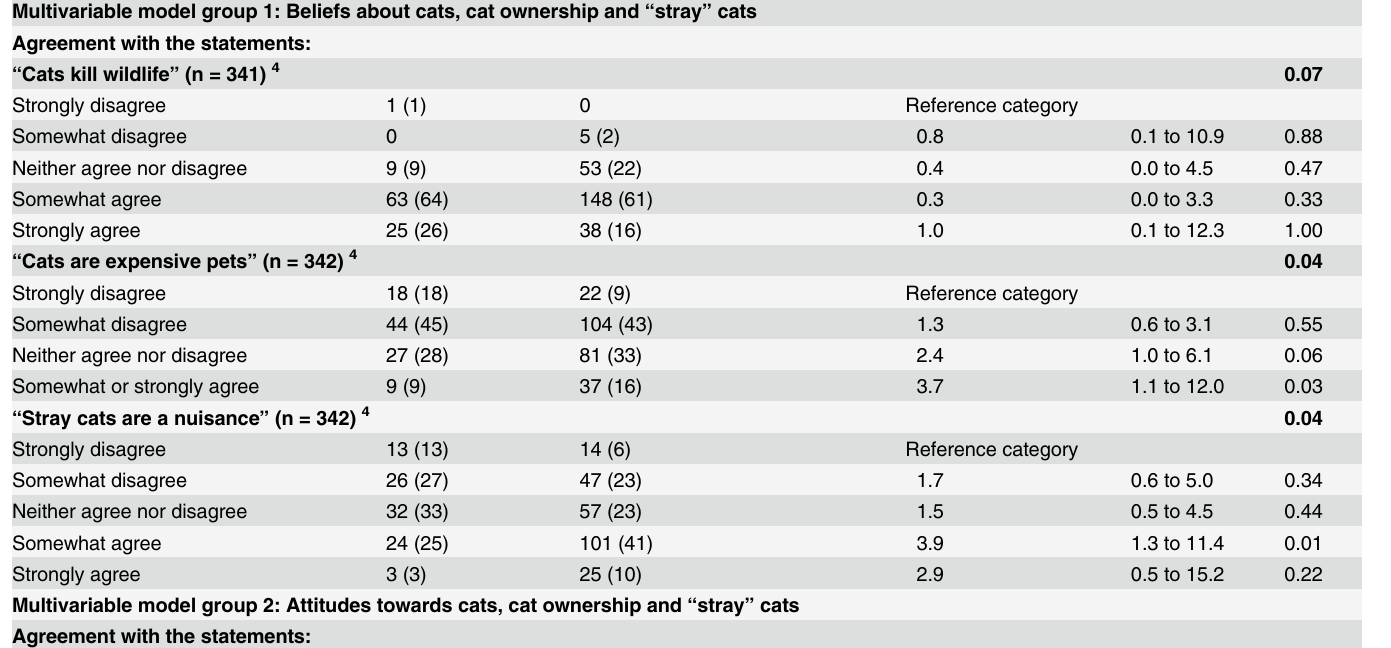
95% Adjusted odds ratio 2 Con fi dence P value 3 interval